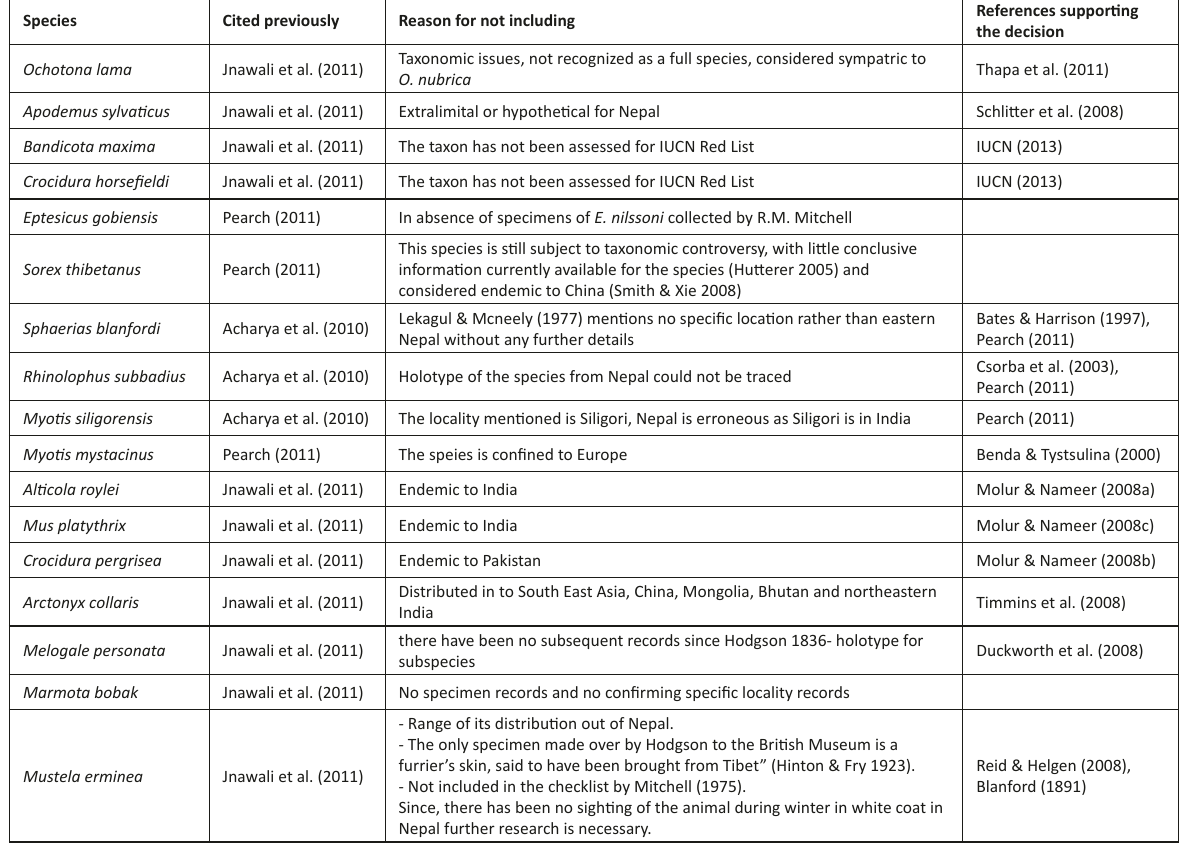
Table 2. Species excluded in the current